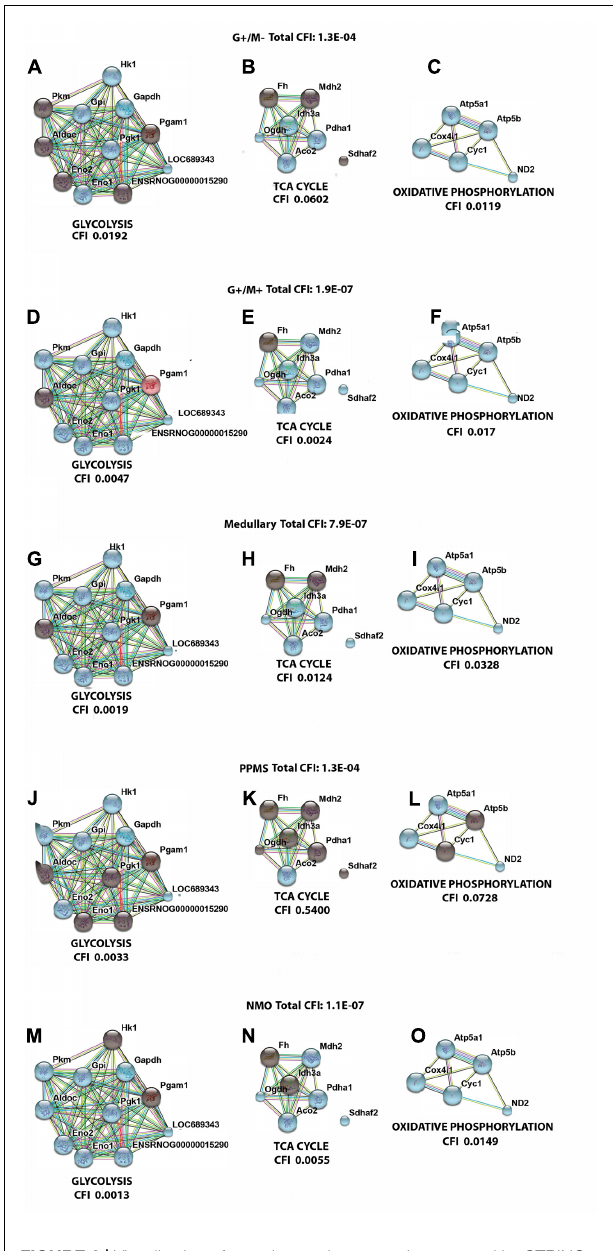
FIGURE 6 | Visualization of gene interaction network generated by STRING v10 in OPCs exposed to CSF from (A–C) G+/M– RRMS; (D–F) G+/M+ RRMS; (G–I) Medullary MS; (J–L) PPMS; (M–O) NMO. Different line colors represent the types of evidence for the association between genes involved in (A,D,G,J,M) glycolysis; (B,E,H,K,N) TCA cycle and (C,F,I,L,O) oxidative phosphorylation in OPCs; Red color signifies upregulated expression, blue color signifies down regulated expression and gray color signifies genes that showed no variation in their expression in our experimental conditions. LOC689343 signifies Pk gene and ENSRNOG00000015290 signifies Tpi